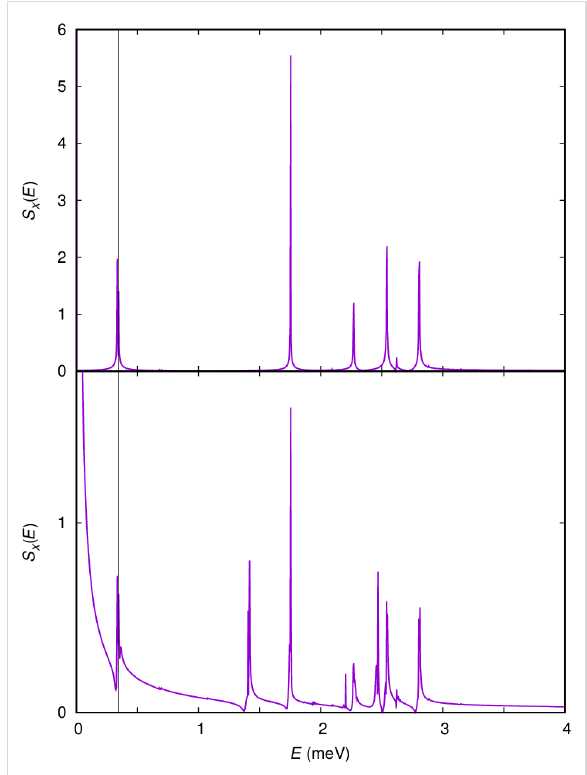
Figure 10: The Fourier power spectrum of the correlation function S x ( τ ) = in the steady state. The cavity photon energy is indicated by a vertical line at 0.343 meV. The constant average photon number in the reservoir = 0 (upper), and = 1 (lower). g EM = 0.05 meV, = 0.343 meV, κ = 1.0 × 10 − 5 meV, B ext = 0.1 T. The spectra are calculated using 5000 time points in the